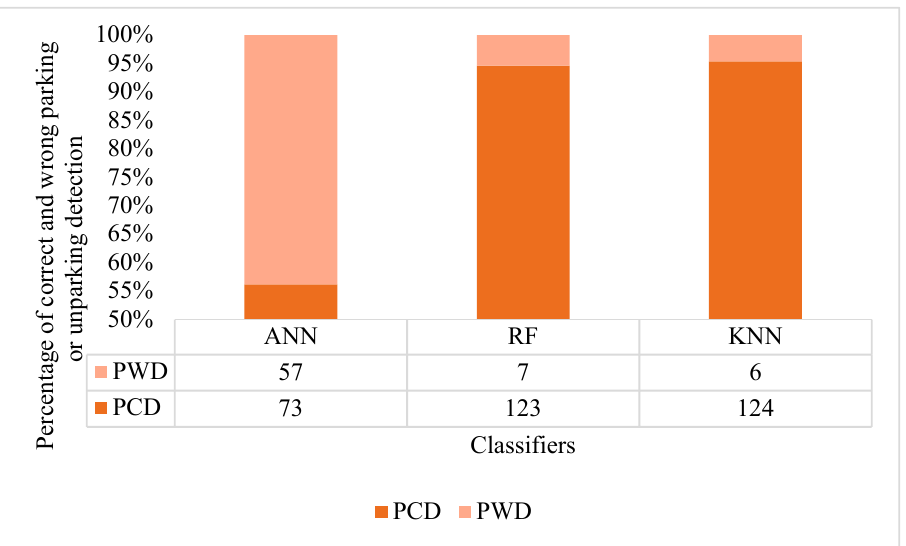
Figure 13. Overall performance of context flow recognition (CFR) as a percentage with each classifier in detecting a parking/unparking action.